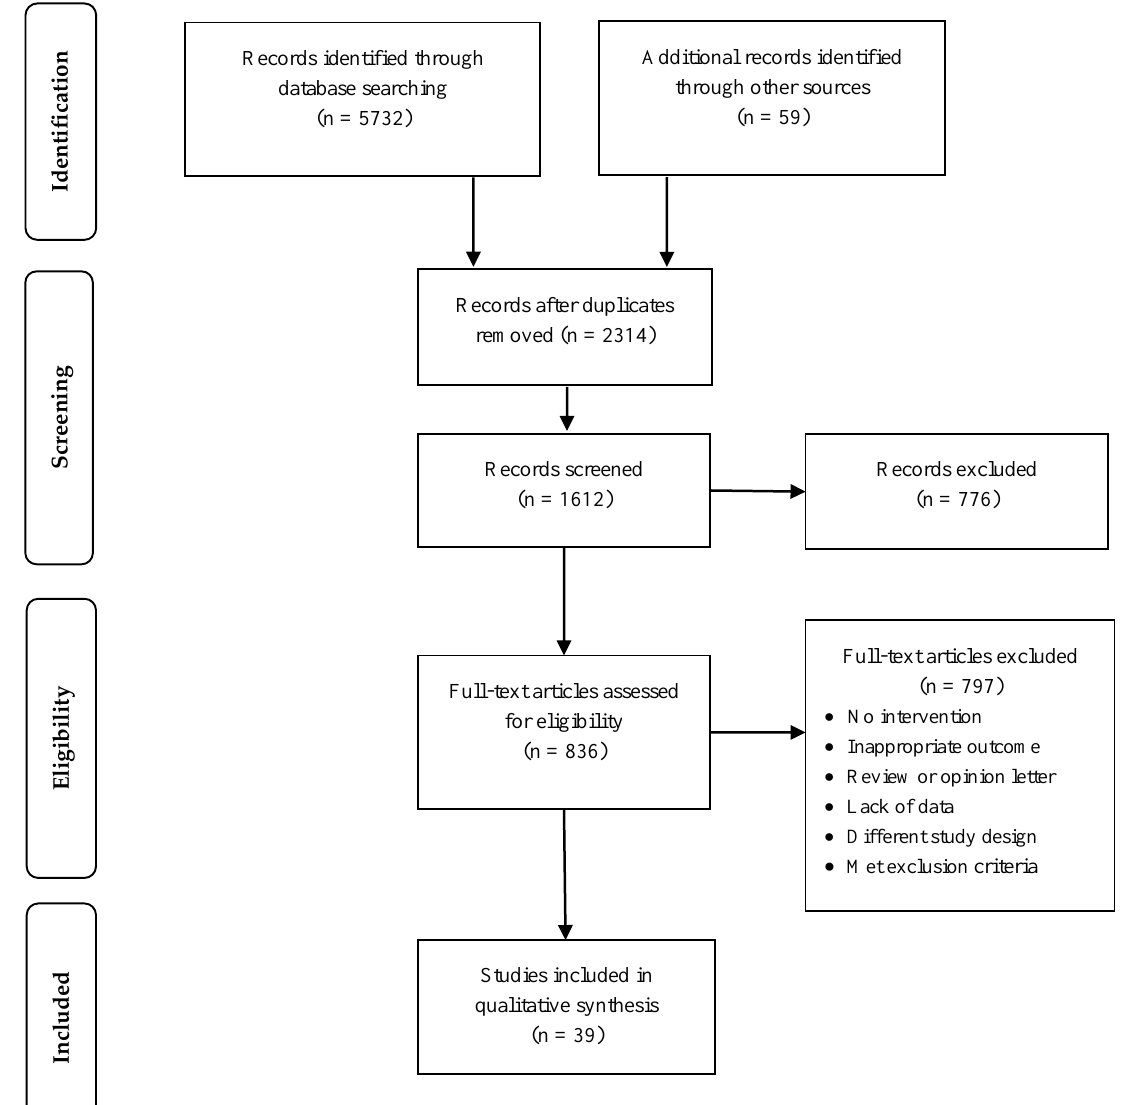
Figure 1. Preferred Reporting Items for Systematic Reviews and Meta-Analyses (PRISMA) flow chart.